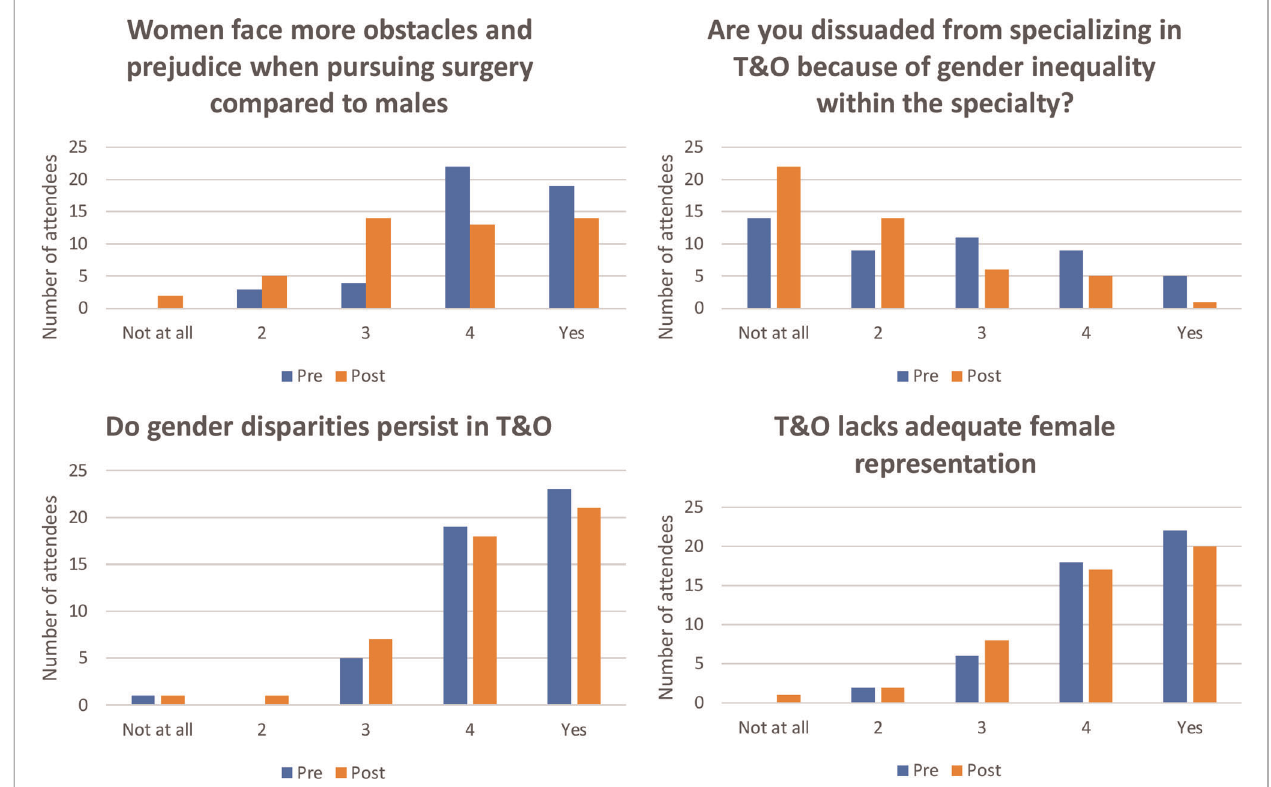
FIGURE 3 | Pre and post event perceptions of T&O